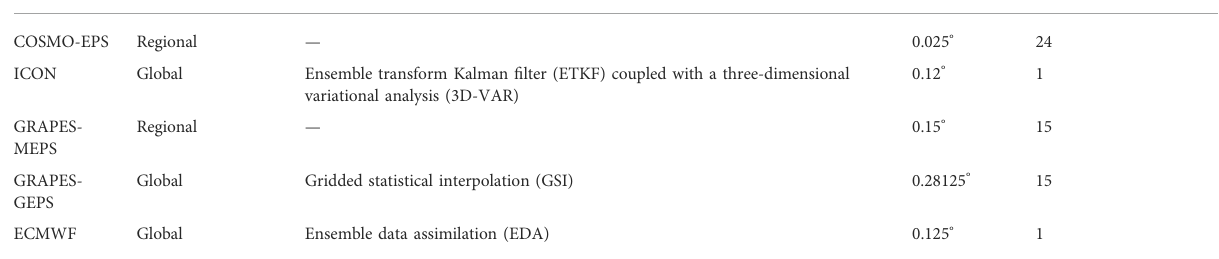
TABLE 4 Various models used for comparisons in this study.